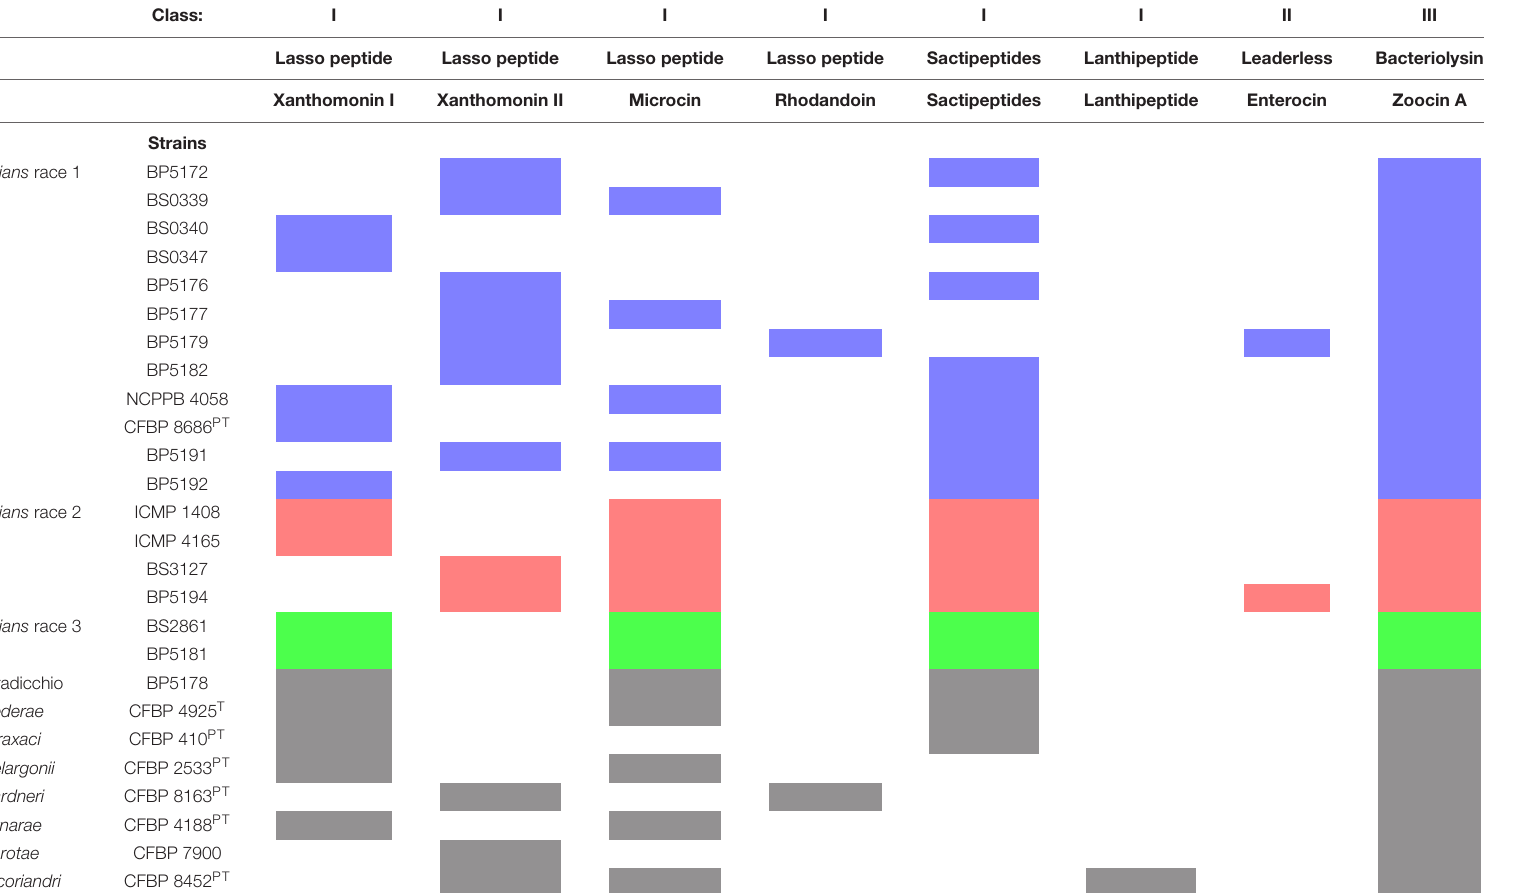
TABLE 5 | Predicted bacteriocin genes.